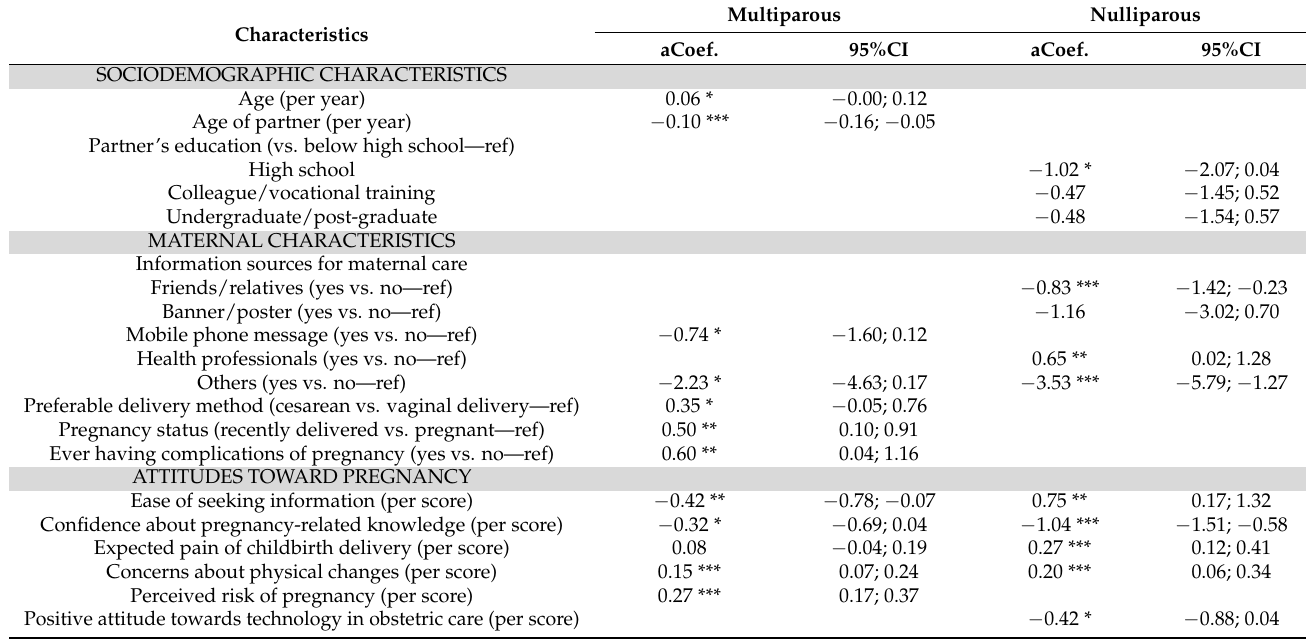
Table 3. Factors associated with fear of childbirth between nulliparous and multiparous pregnant women.